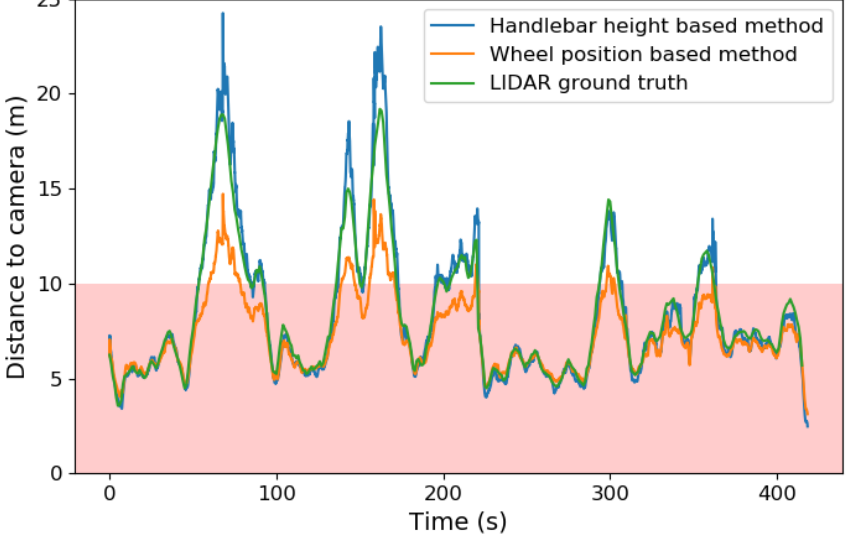
Figure 12. Measured distances on our dynamic test sequence. The draft zone is colored pink. The LiDAR data is considered ground